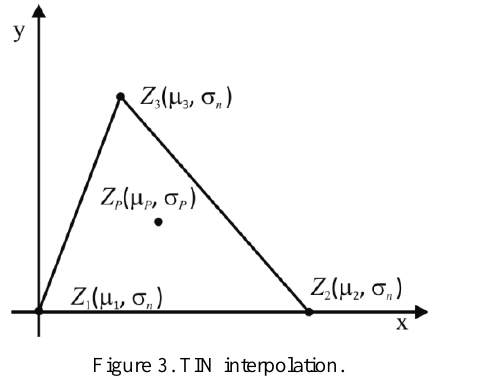
Figure 3. TIN interpolation.